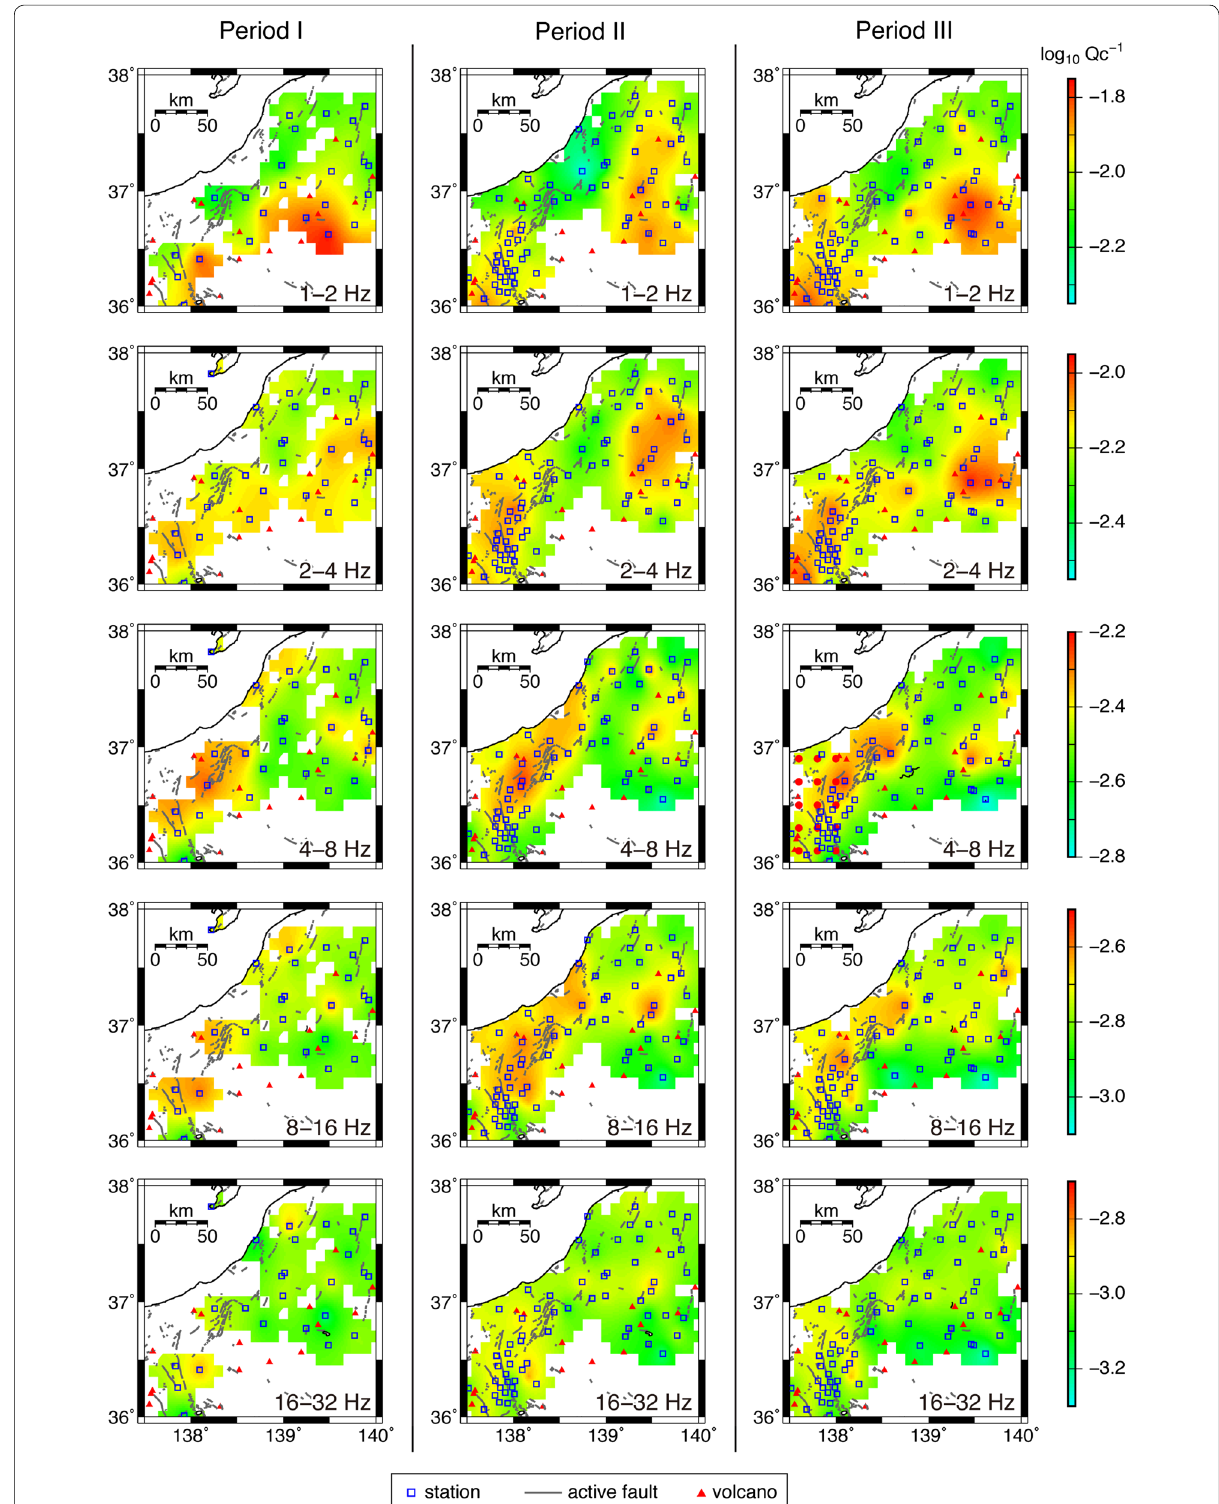
Fig. 3 Spatial distributions of coda Q − 1 at five frequency bands in the Period I (left panels), the Period II (middle panels), and the Period III (right panels; Dojo and Hiramatsu 2017). Blue squares are stations used to draw the coda Q maps. Gray lines show Quaternary active faults, and red triangles show Quaternary active